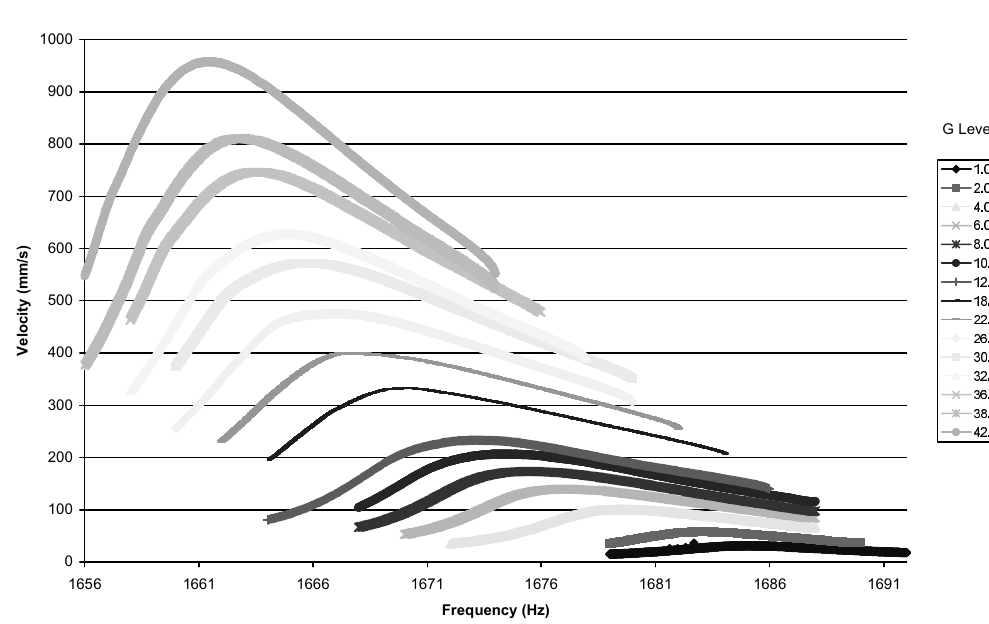
Fig. 8. Sine sweeps for plate T3: Mode 4: Uncoated and coated.